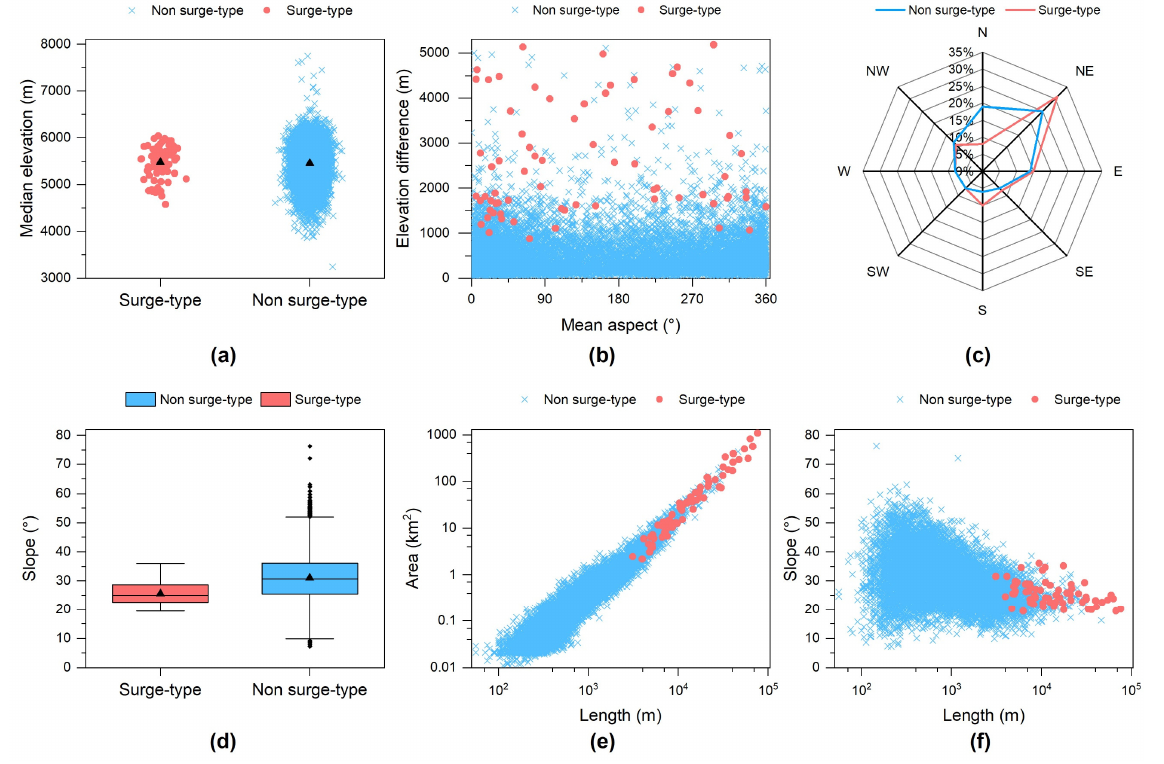
Figure 11. Geometry characteristics of surge-type and nonsurge-type glaciers in the study area: ( a ) distribution of median elevation; ( b ) scatterplot of elevation difference (the difference between maximum and minimum) versus mean aspect; ( c ) distribution of glacier aspects; ( d ) mean slope comparison; ( e ) scatterplot of area vs. length; ( f ) scatterplot of mean slope vs. length. Please note the logarithmic scale of the ( e , f ) x ‐ axis and ( e ) y ‐ axis.